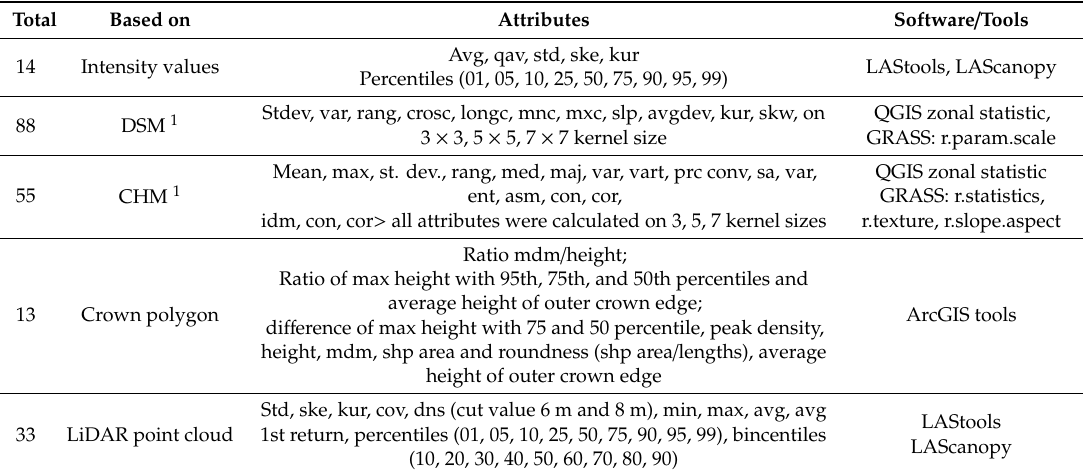
Table A1. LiDAR attributes (203